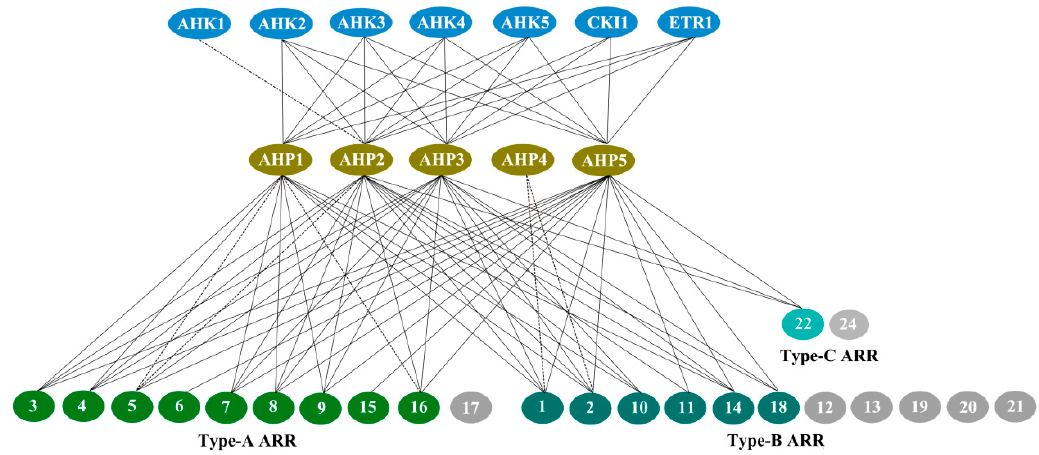
Figure 7. Protein–protein interaction network of two-component systems (TCS) signaling pathway in Arabidopsis . Interactions confirmed both in in vitro and in vivo are indicated by a line, while interactions found only in the Y2H analysis are indicated by dashed lines. Shaded oval shapes represent proteins not studied.